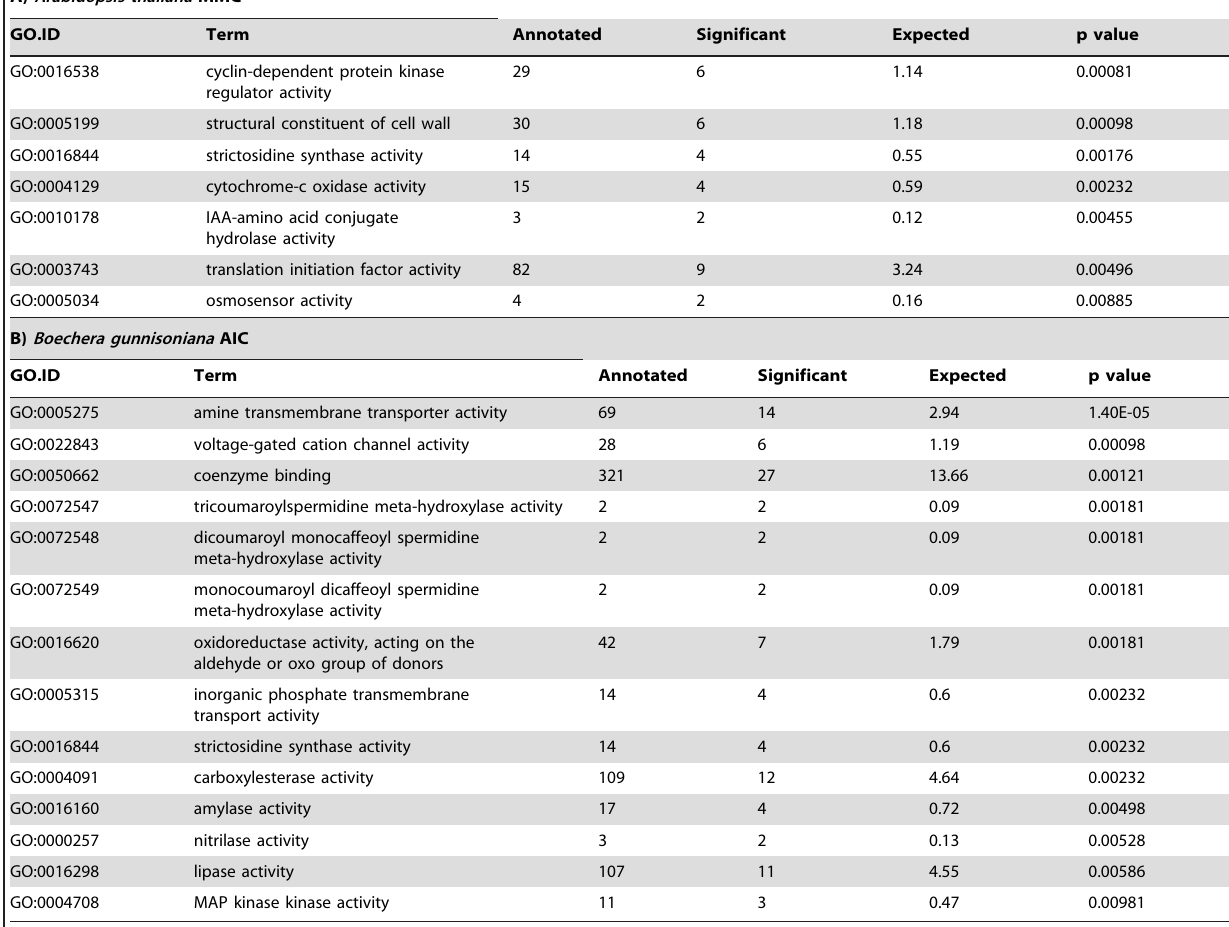
Table 3. Gene ontology analysis on MMC and